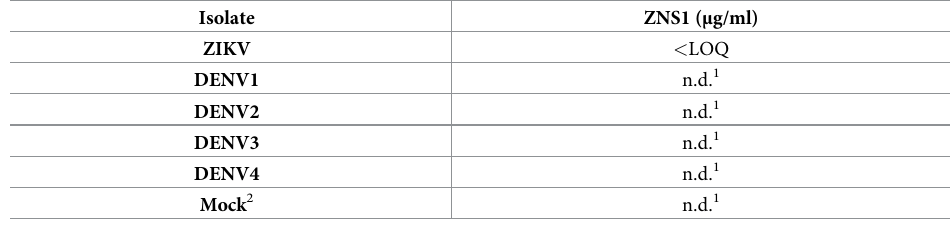
Table 3. ZNS1 detection in supernatants from A549 infected cells by indirect competitive ELISA with 1F5 mAb.